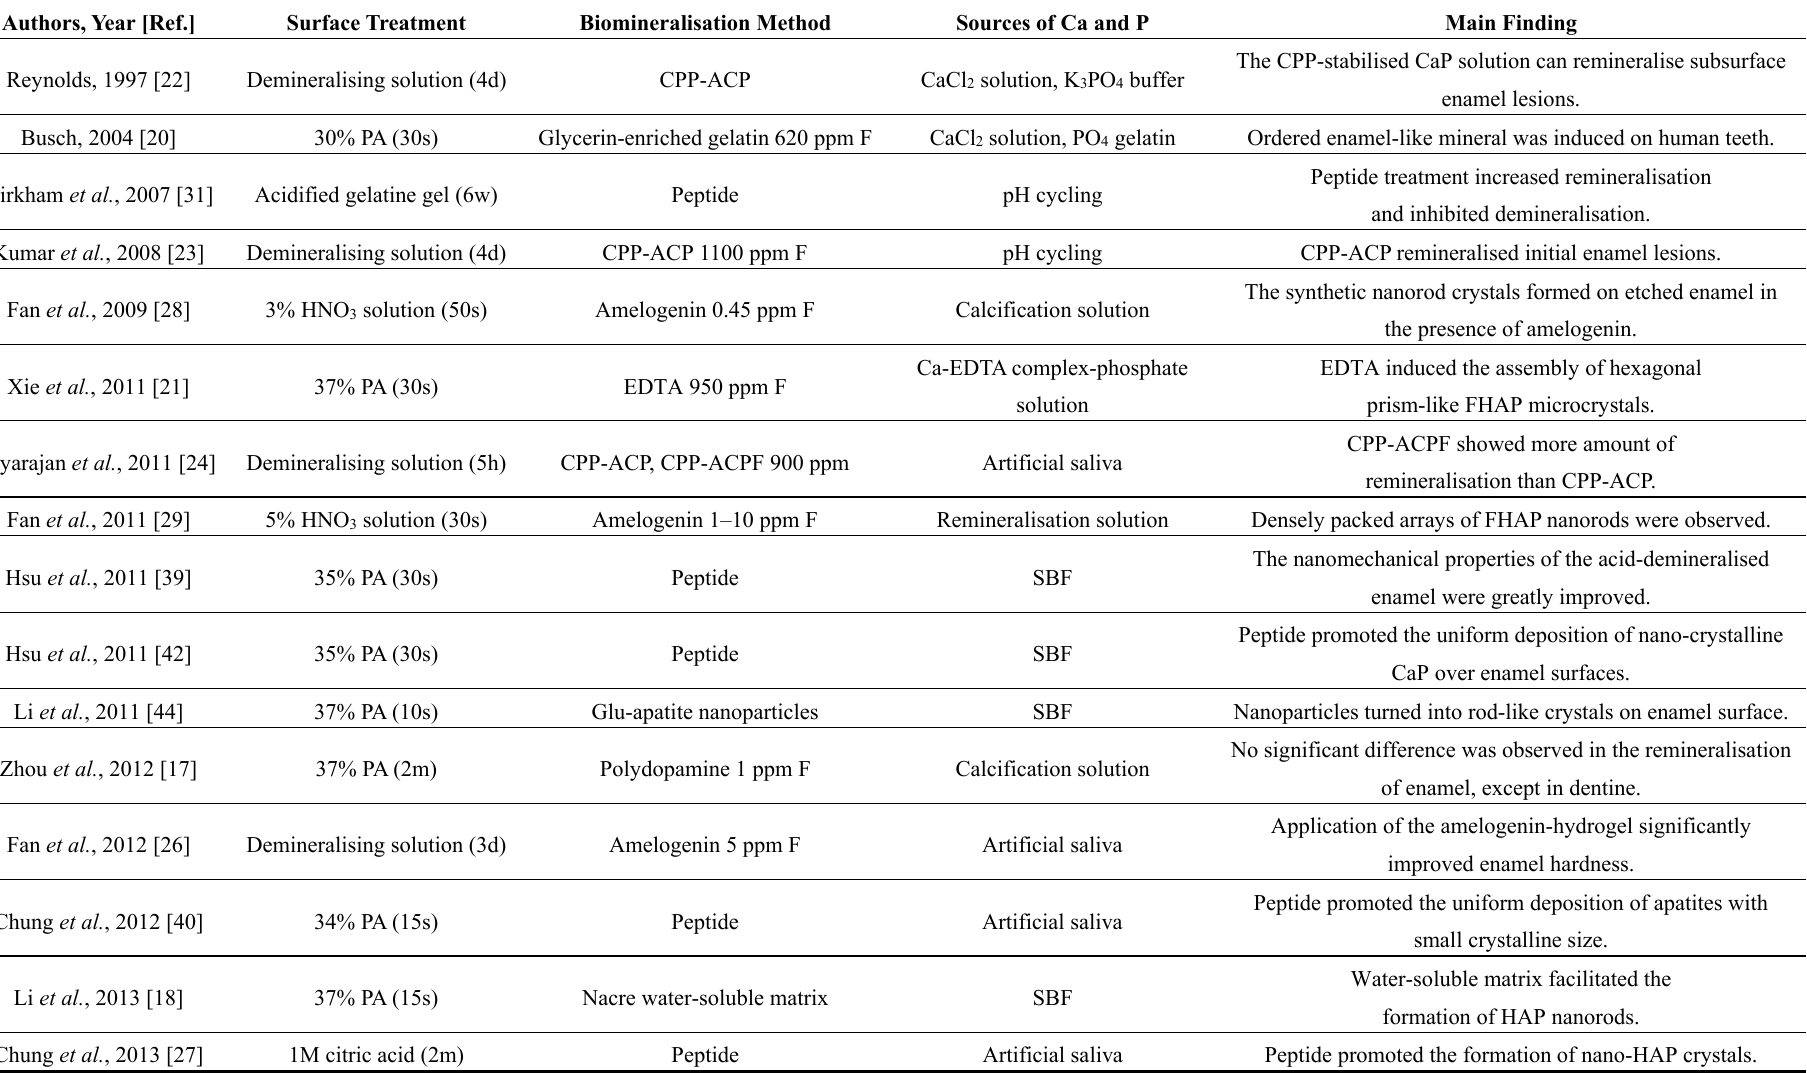
Table 1. Summary of the in vitro studies on biomimetic mineralisation on human